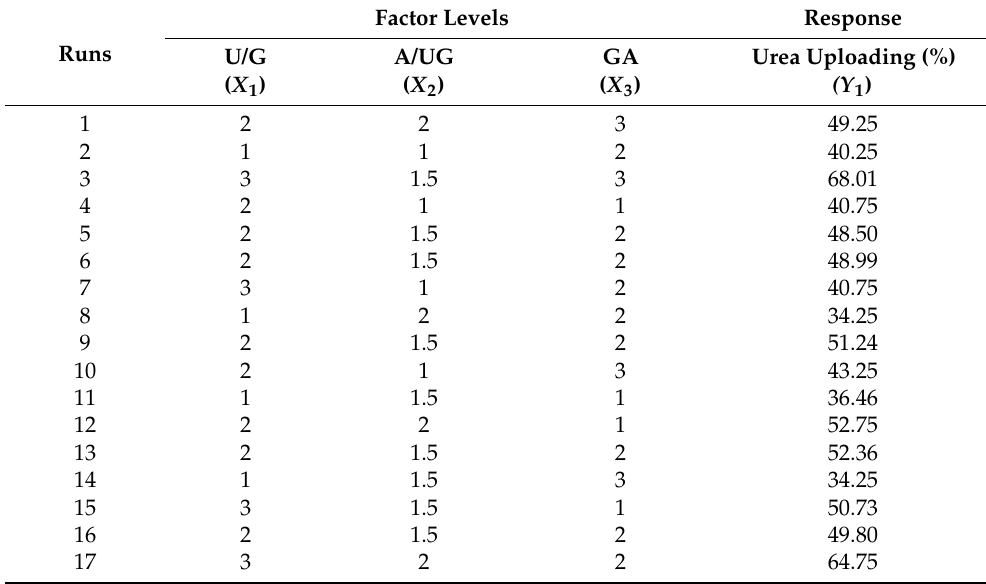
Table 2. Runs, factor levels, and response variable for the Box–Behnken experimental design. Factor Levels Runs